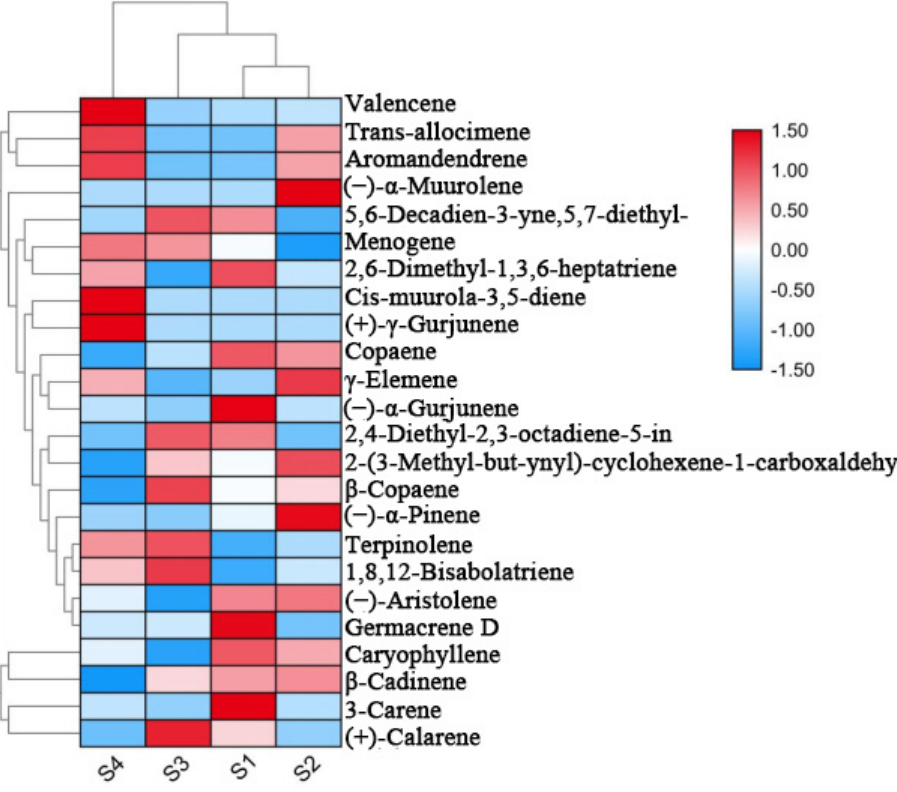
Figure 2. Heat map and hierarchical cluster analysis of floral fragrance compounds in the flowers of P. notoginseng (>1%).